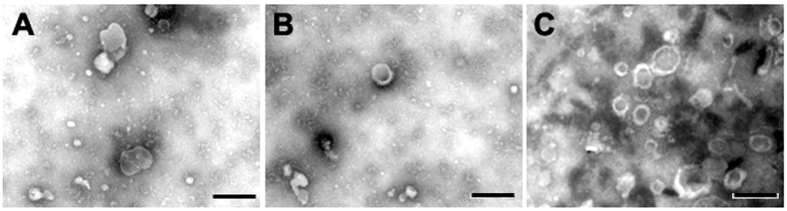
Micrographs of scanning electron microscopy of (A) maMSC-Exos, (B) hucMSC-Exos and (C) f-Exos show spheroid shaped vesicles at the diameter of about 40–100 nm. Scale bar = 200 nm.